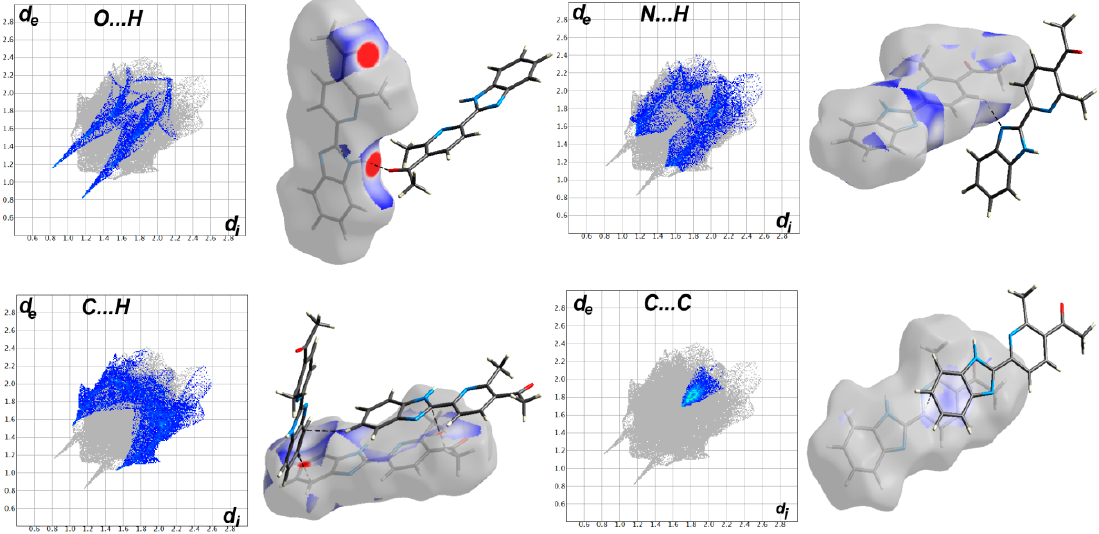
Figure 5. The O…H, C…H, C…C, and N…H interactions in 3 observed using Hirshfeld analysis.